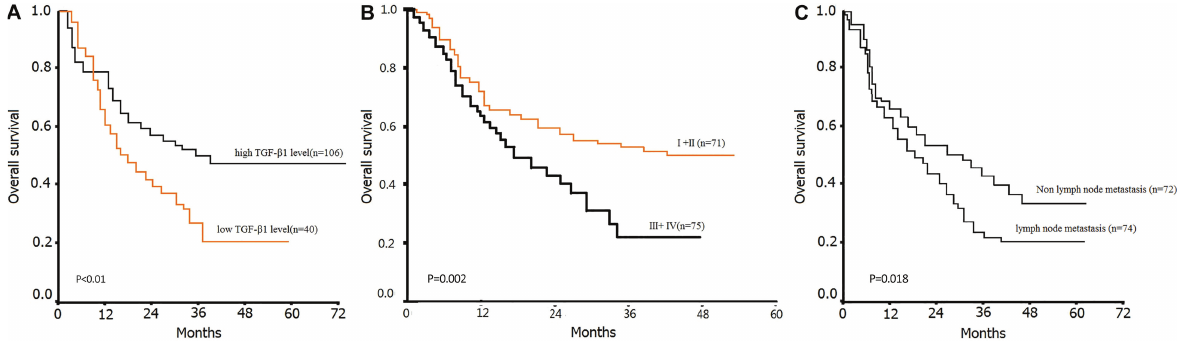
Figure 2. Kaplan Meier survival curve for low and high TGF- b 1 levels in plasma of pancreatic ductal adenocarcinoma patients ( A ), for patients with stage I and II or stage III and IV ( B ), and for pancreatic cancer patients with lymph node metastasis and non-lymph node metastasis ( C